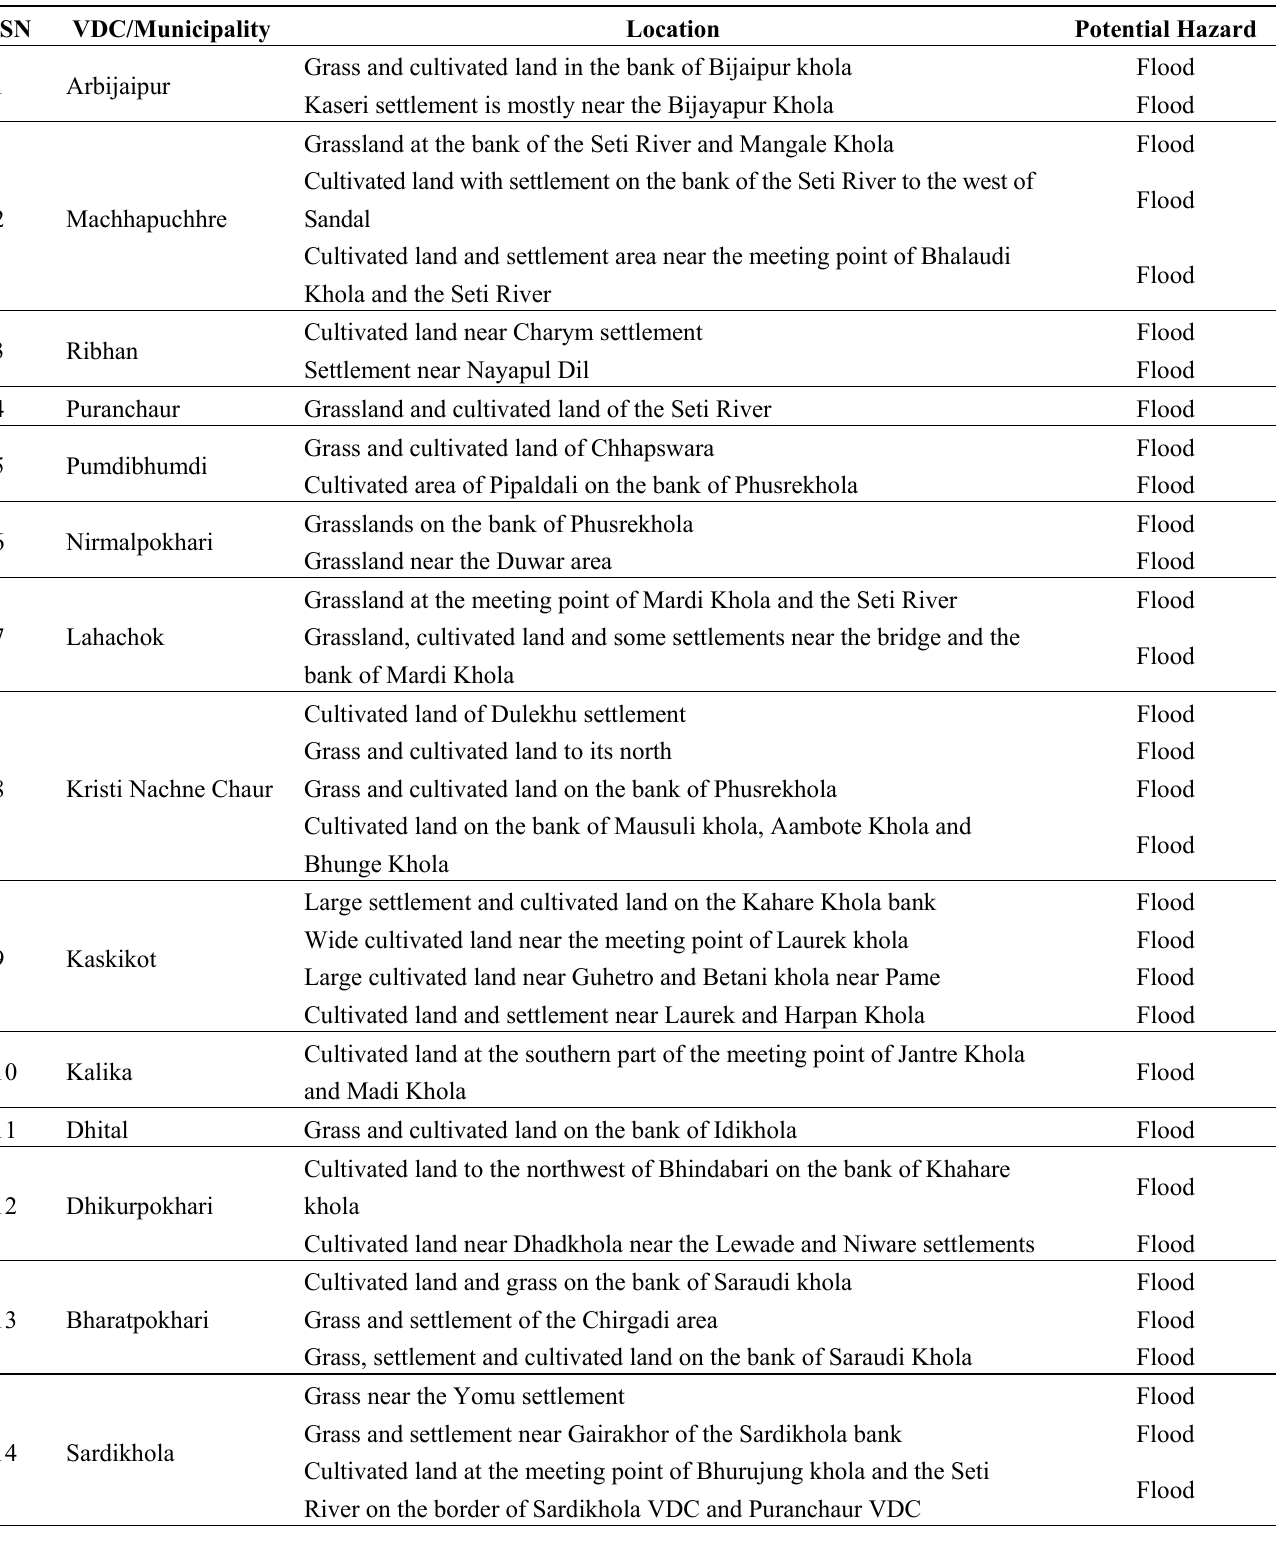
Table 3. Flood hazard prone